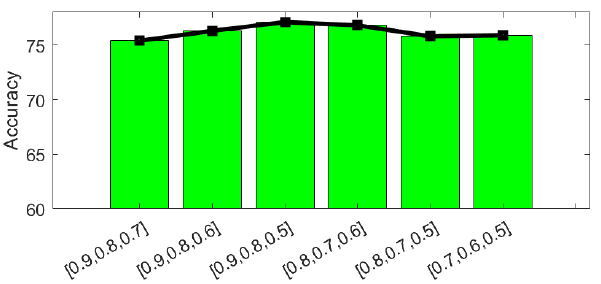
Figure 6. Effect of different p t on test accuracy.